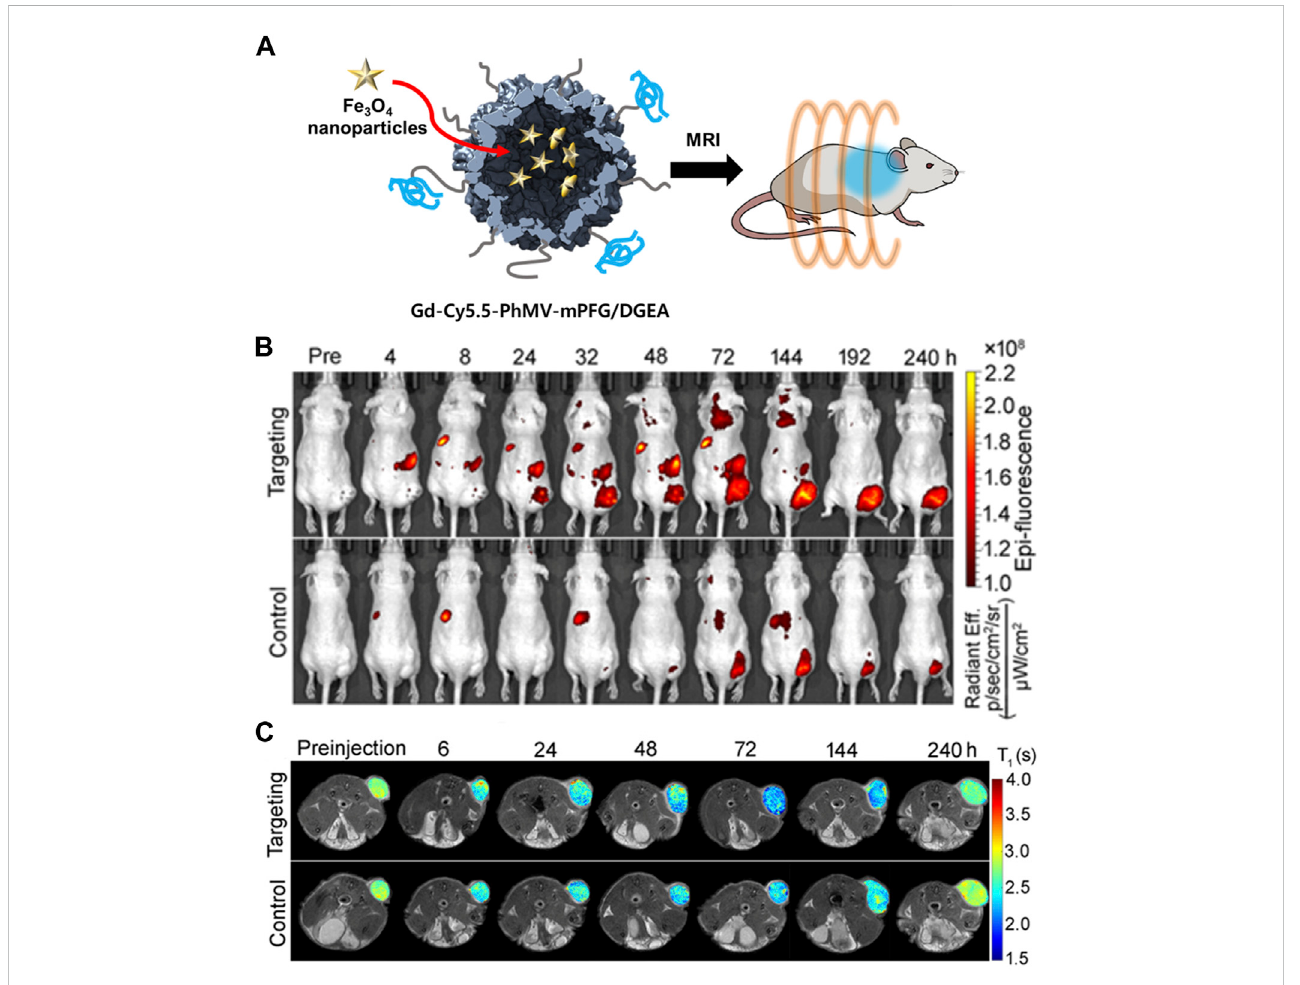
FIGURE 6 (A) Schematic illustration of Gd-Cy5.5-PhMV-mPEG NPs for cancer imaging. (B) In vivo NIR fl uorescence images of PC-3 prostate tumors in athymic nude mice after the intravenous injection of Gd-Cy5.5-PhMV-DGEA. (C) In vivo T1-map of PC-3 prostate tumors in athymic nude mice after the intravenous injection of Gd-Cy5.5-PhMV-DGEA. Reprinted with permission from Hu et al. (2019a). Copyright (2019) American Chemical